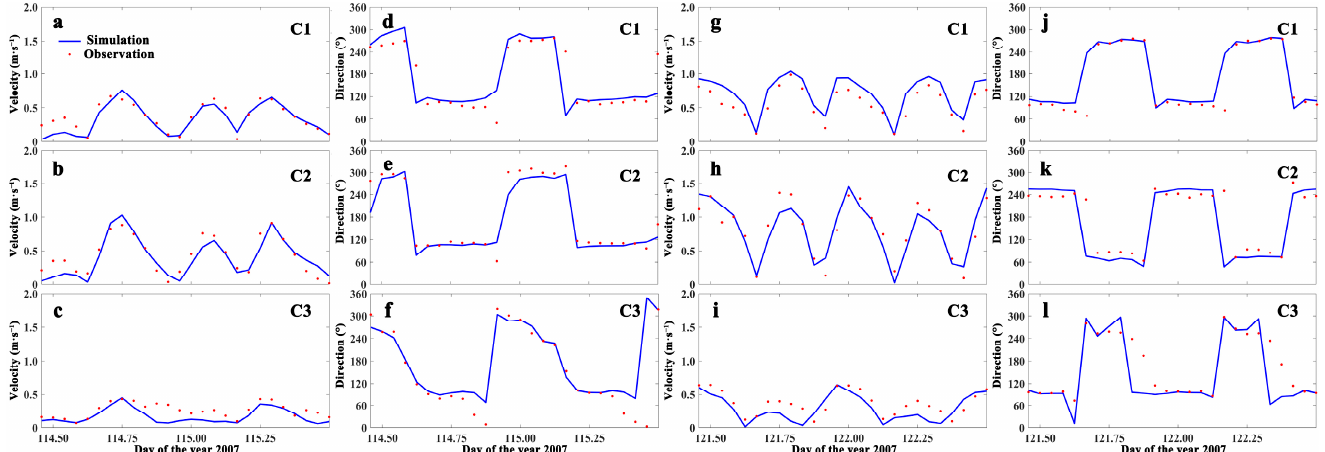
Figure 4. Observed (dot red line) and simulated (solid blue line) vertical averaged current velocity and current direction during neap tide ( a – c current velocity in m·s − 1 ; d – f current direction in degree) and spring tide ( g – i current velocity in m·s − 1 ; j – l current direction in degree) at the C1~C3 stations.